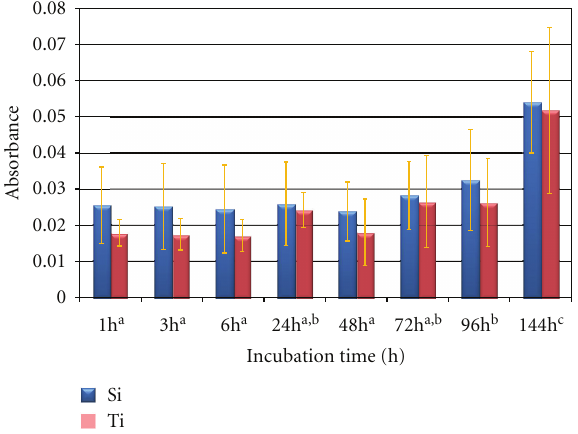
Figure 3: Color marker release as a function of incubation